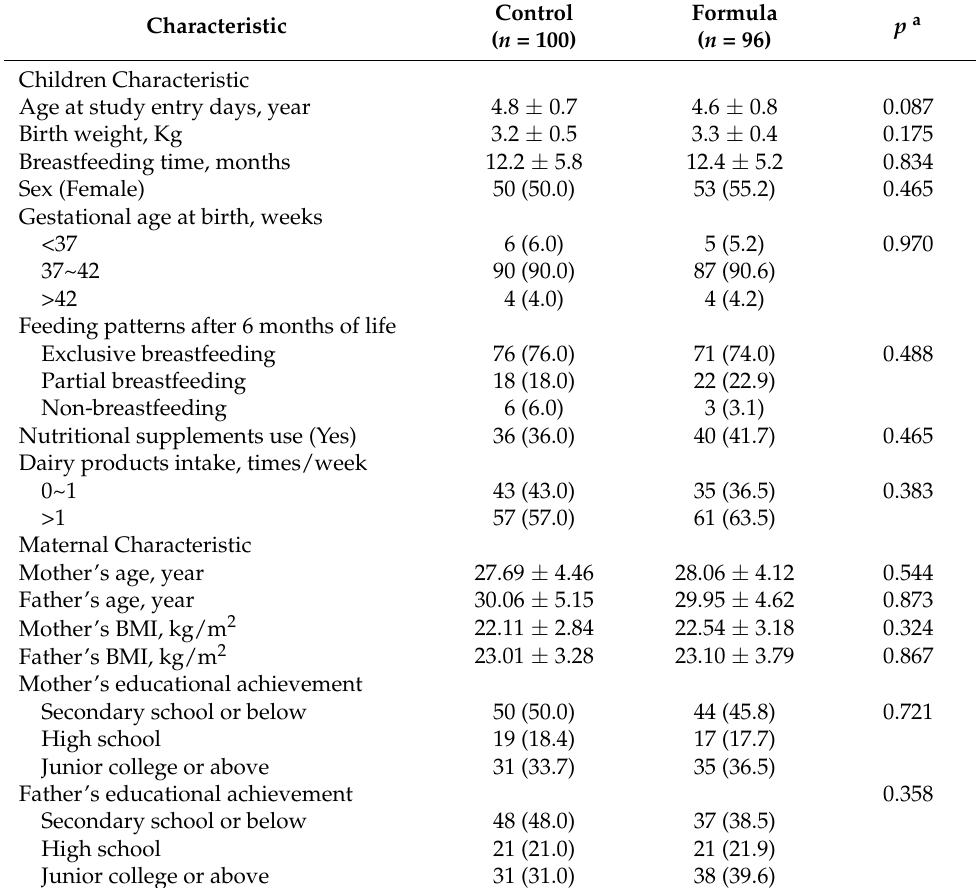
Table 1. Baseline characteristics of study participants and their parents.